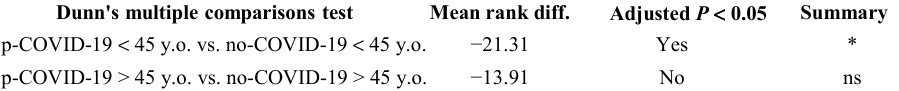
Figure 2. Plasma 25(OH)D levels among COVID-19 positive and COVID-19 negative participants in di ff erent age groups; * p = 0.0492, ns = not signi fi cant; y.o. = years old. The 25(OH)D levels in men and women were comparable in general (21.84 ± 33.72 ng/mL vs. 23.84 ± 32.01 ng/mL; p = 0.9989). This trend also persisted when comparing with groups ( p = 0.0636; Figure S2).